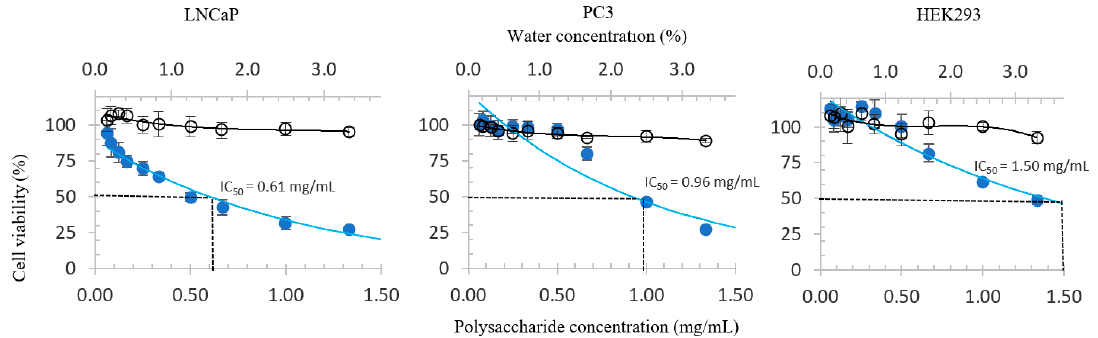
Figure 1. Dose-response curves of WCP in LNCaP, PC3, and HEK293 cell lines. The blue and black circles represent the growth inhibitory properties of the WCP and solvent control (water), respectively.